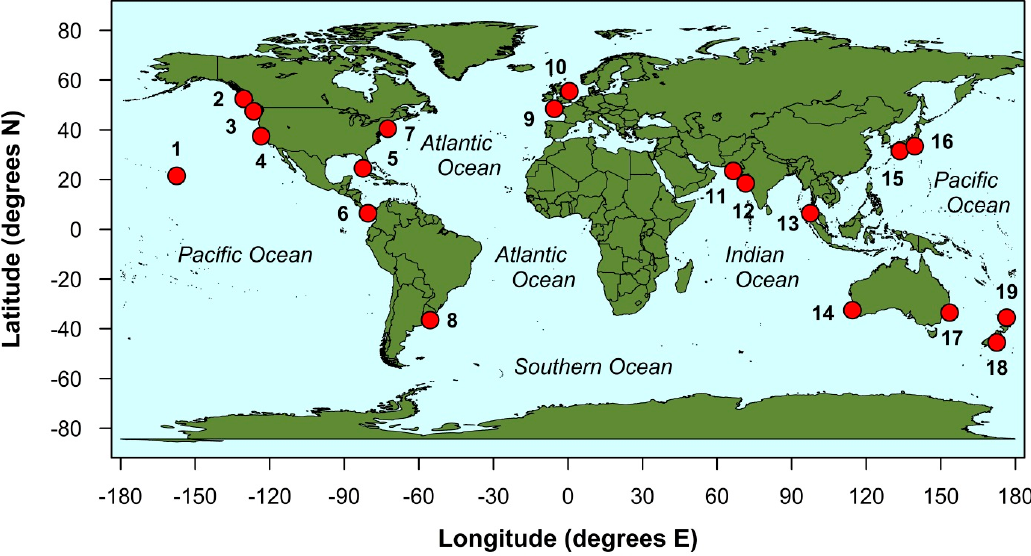
Figure 1. Location of analysis sites used in the study. Sites have been delineated with a station “ID” commencing with 1 (Honolulu, HI, USA) moving easterly to 19 (Auckland, New Zealand). Full details of data records are summarized in Table 1.